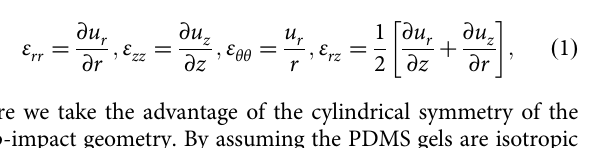
data point represents the average result of total 15 different experimental runs.